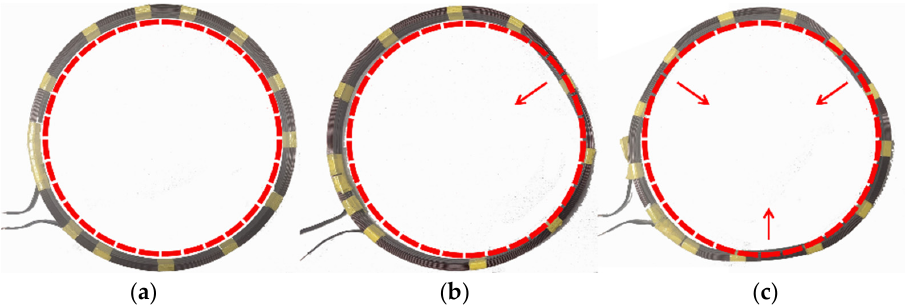
Figure 3. Winding 1 sections: ( a ) healthy section: ( b , c ) radially deformed sections.